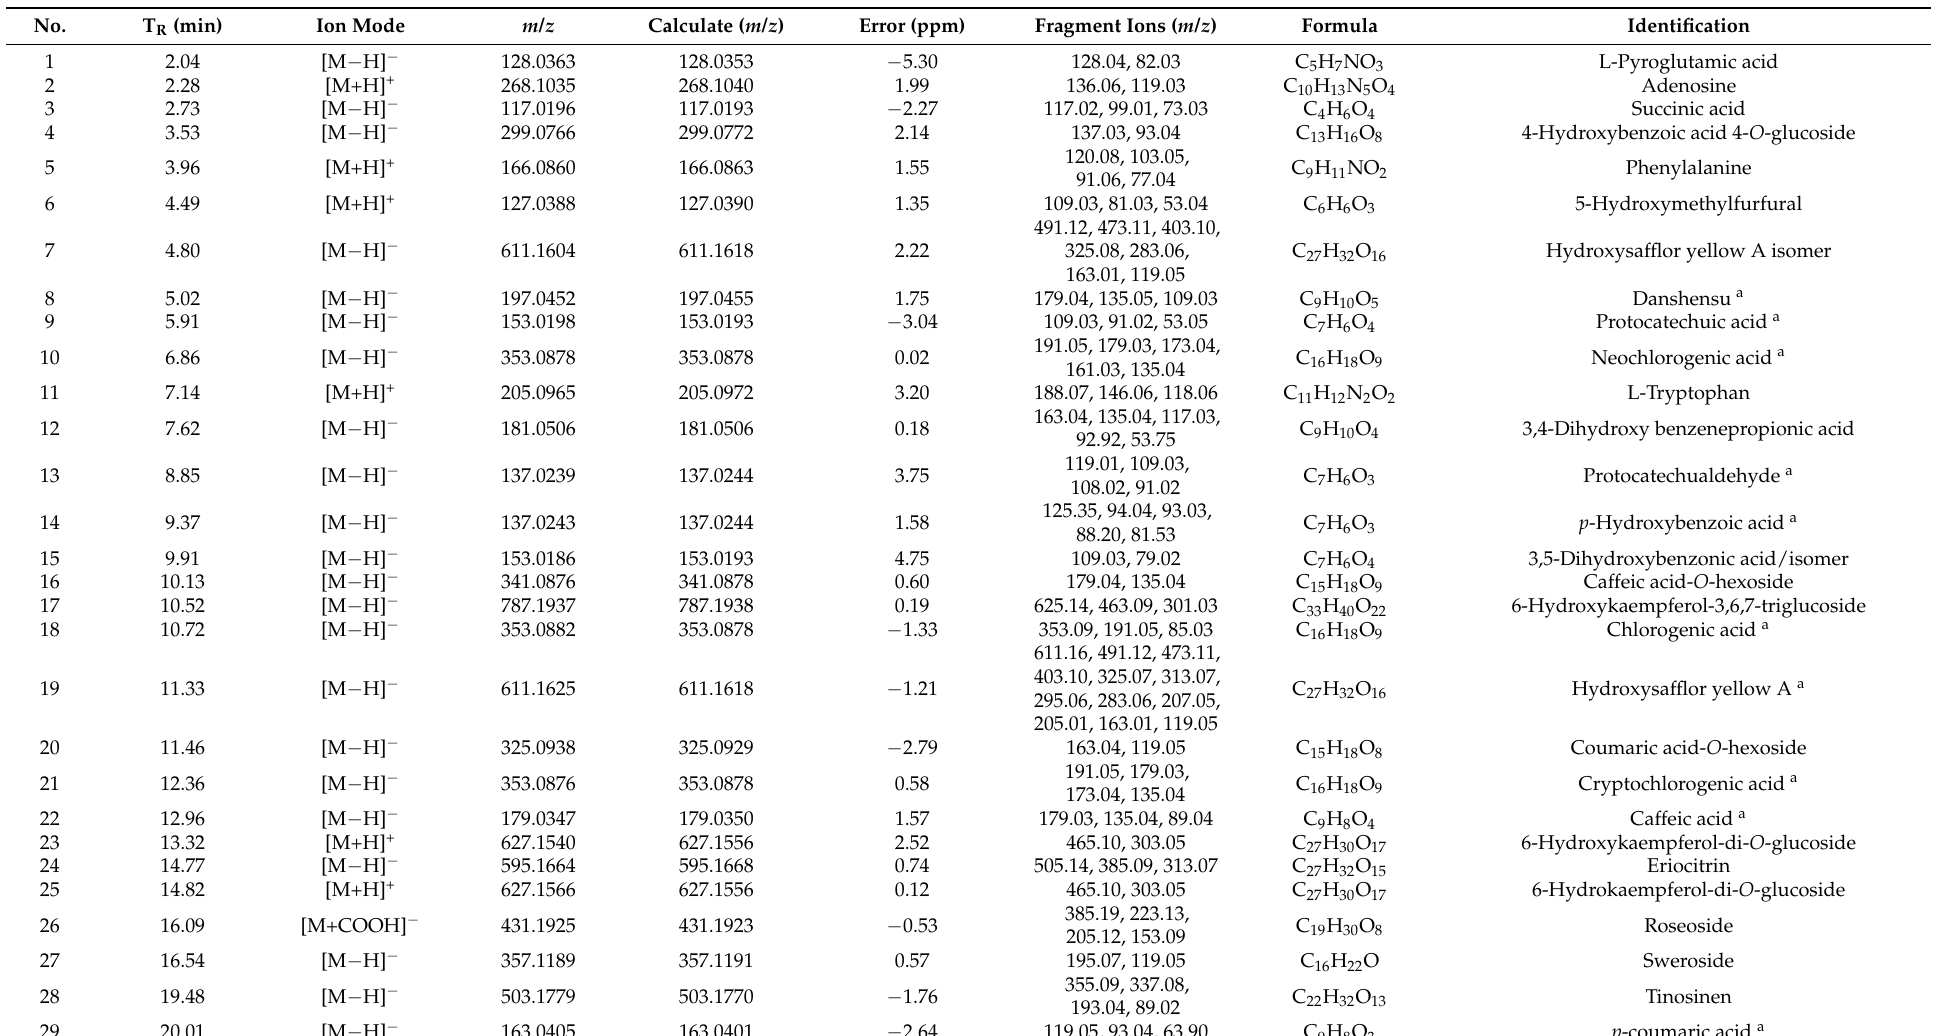
Table 1. Component identification of the Danshen-Honghua (DH) herbal